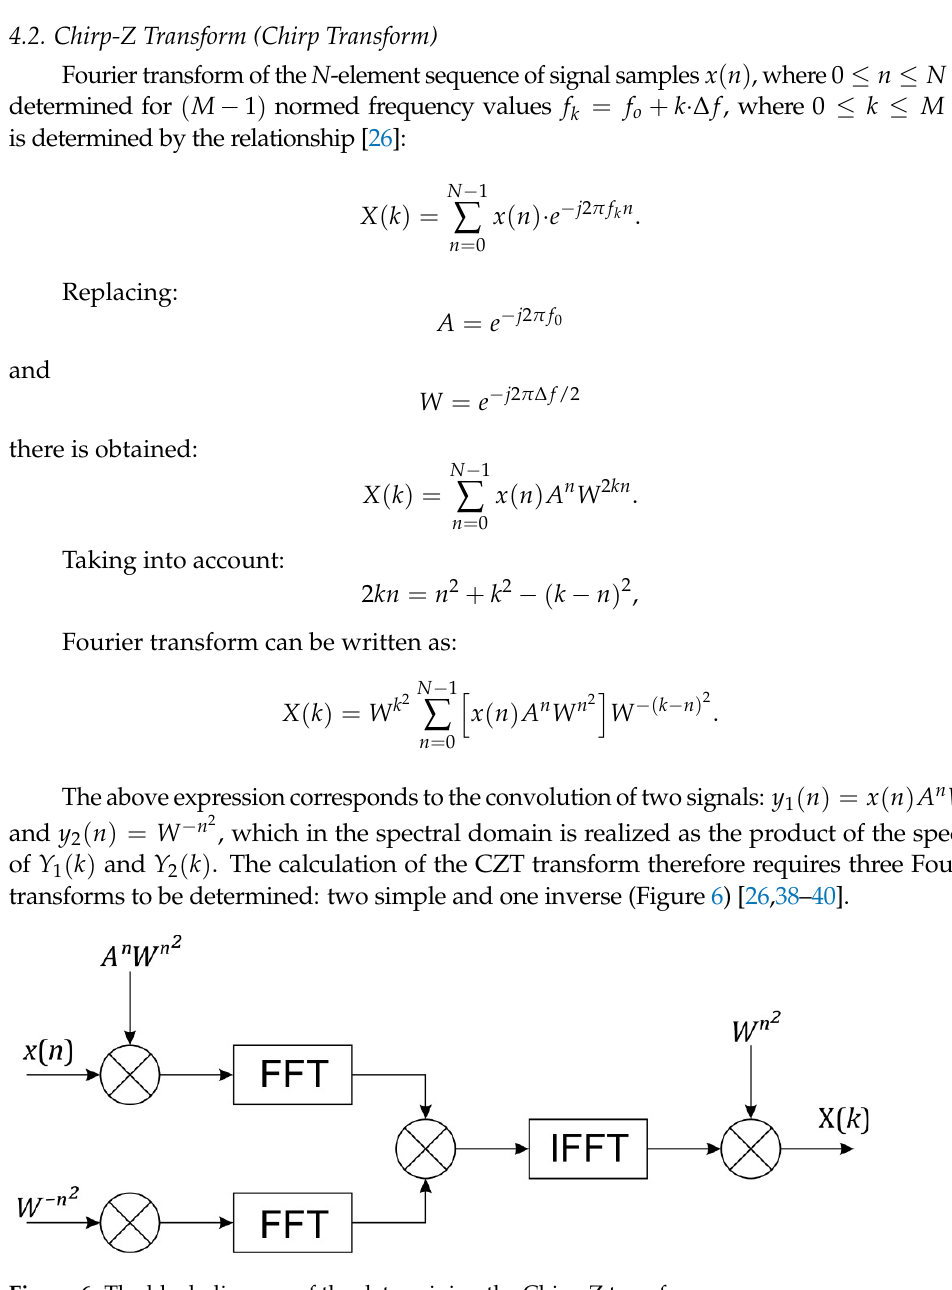
Figure 6. The block diagram of the determining the Chirp-Z